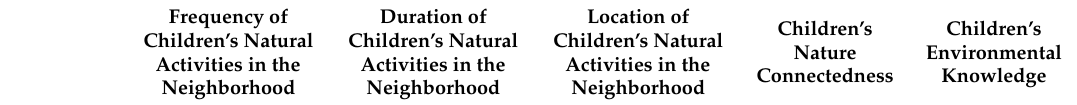
Table 2. Two-tailed Pearson correlation of three children’s natural activity parameters with each other and with children’s nature connectedness and environmental knowledge.